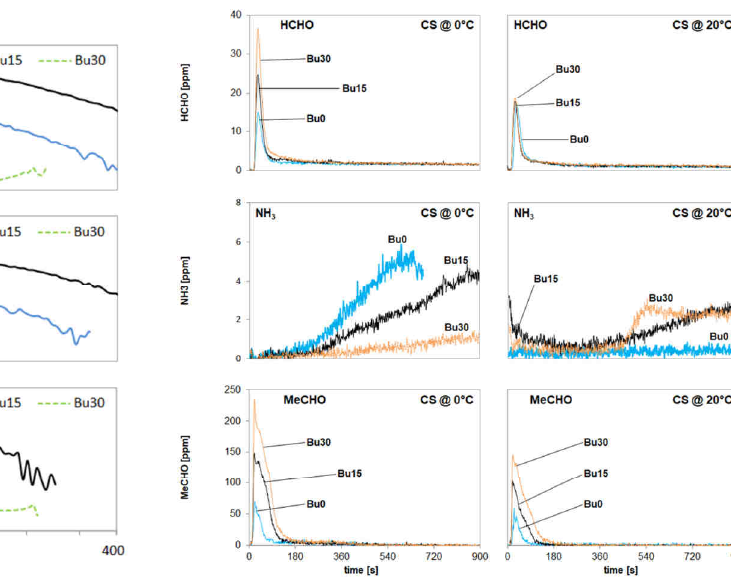
Fig. 13. Comparison of the Particle Size Distribution (PSD) during the driving cycle SSC with different fuels